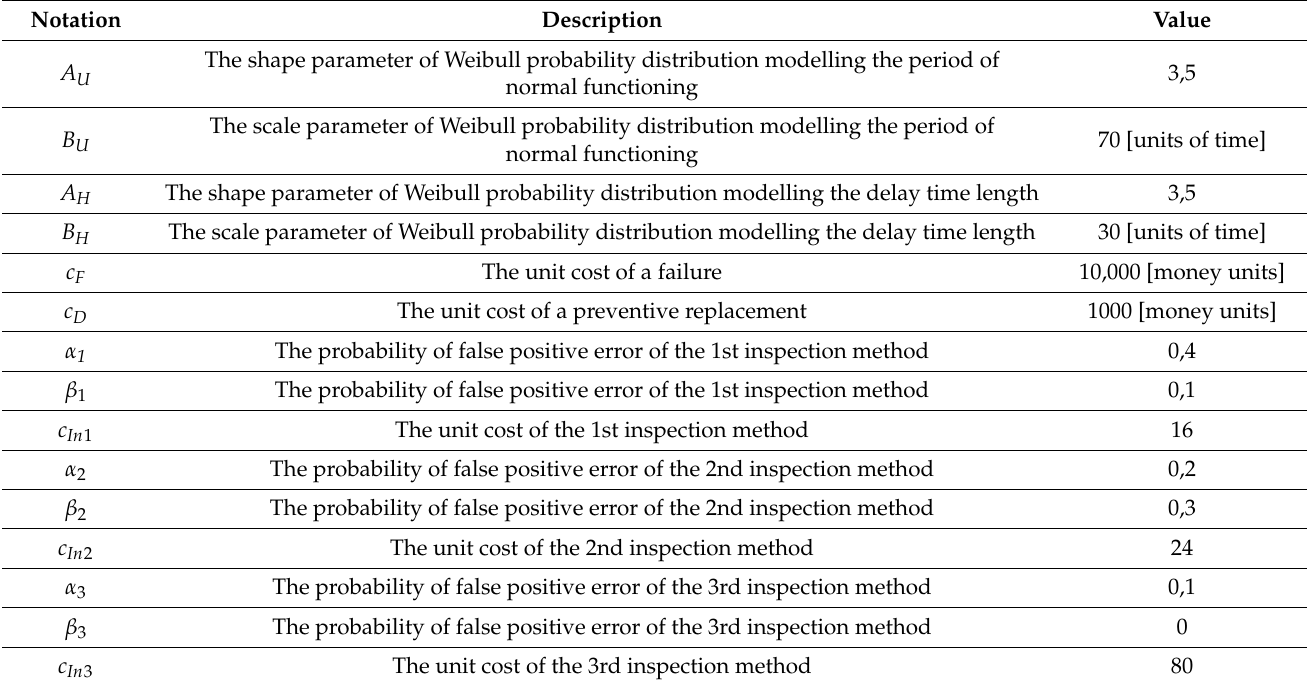
Table 4. Parameters of system reliability, costs, and accuracies of inspection